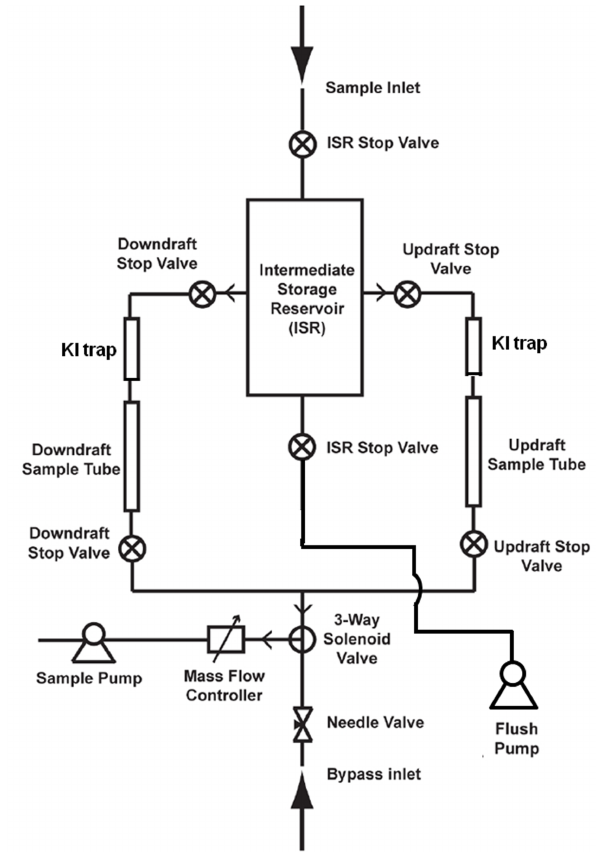
Fig. 1. Schematic diagram of the DEA sampling instrument. The sampler measures 50cm × 40cm × 15cm and weighs ∼ 50kg and is housed in a protective all weather case (Pelican model 1600NF) cooled via computer CPU fans (NMB-MAT